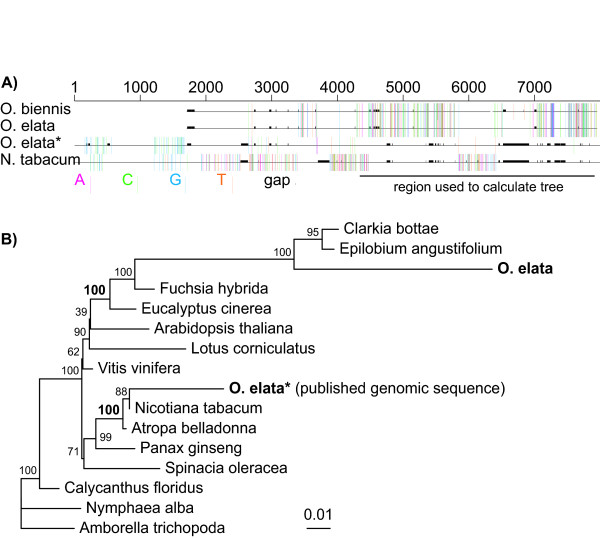
Error in the published Oenothera elata ycf2. (A) Alignment of ycf2 nucleotide sequences: The top two sequences, Oenothera biennis and O. elata, were sequenced as part of this study. We did not sequence the first ~1600 bp. The bottom two sequences correspond to the published Oenothera elata and Nicotiana tabacum sequences. The bottom three sequences were used to determine a consensus base at each position, and positions that did not match this consensus are colored as denoted in the key. (B) All codon position ML tree using the TVM+G model in PAUP* with 100 bootstrap replicates. Only the 3' region of ycf2 starting at position 4023 of the published Oenothera sequence [31] was obtained for the four Myrtales taxa (Eucalyptus, Fuchsia, Clarkia and Epilobium) and the analysis was performed using this region of aligned positions as indicated in (A). Within this region, gappy positions were removed prior to phylogenetic analysis, which resulted in 2567 positions. When the entire gene was used with the published Oenothera sequence excluded, the topology was the same except that the Lotus and Arabidopsis branches were switched. When the published Oenothera is included in the full-length analysis, its strong chimerism pulled Clarkia, Epilobium and our elata sequence into an artifactual clade with the published elata gene at the base of the Solanaceae.